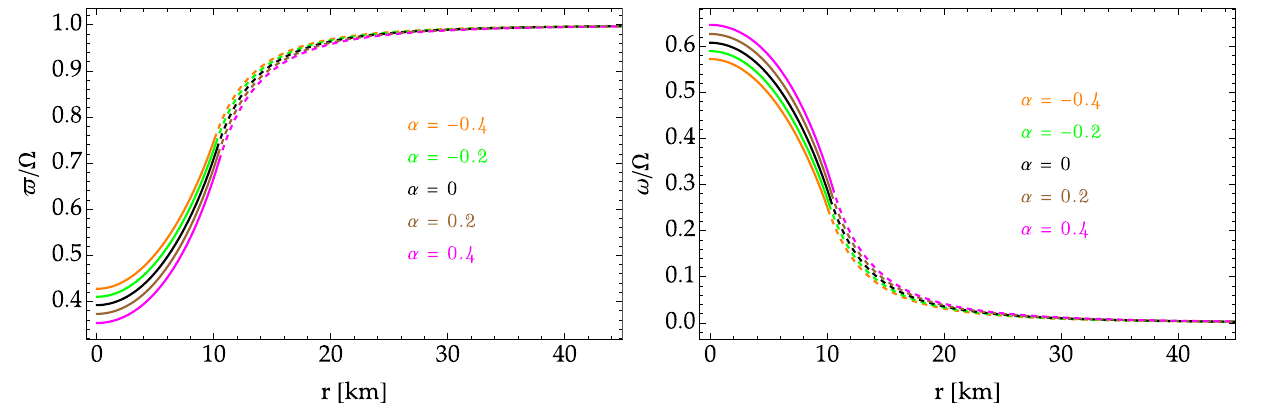
ω( r )/(cid:18) = 1 − (cid:19)( r )/(cid:18) . It can be observed that the outer solution behaves asymptotically at large distances from the surface of the star (this is, ω → 0 for r → ∞ ). Furthermore, appreciable changes in the angular velocity due to anisotropy can be noticeable, mainly in the interior region of the star